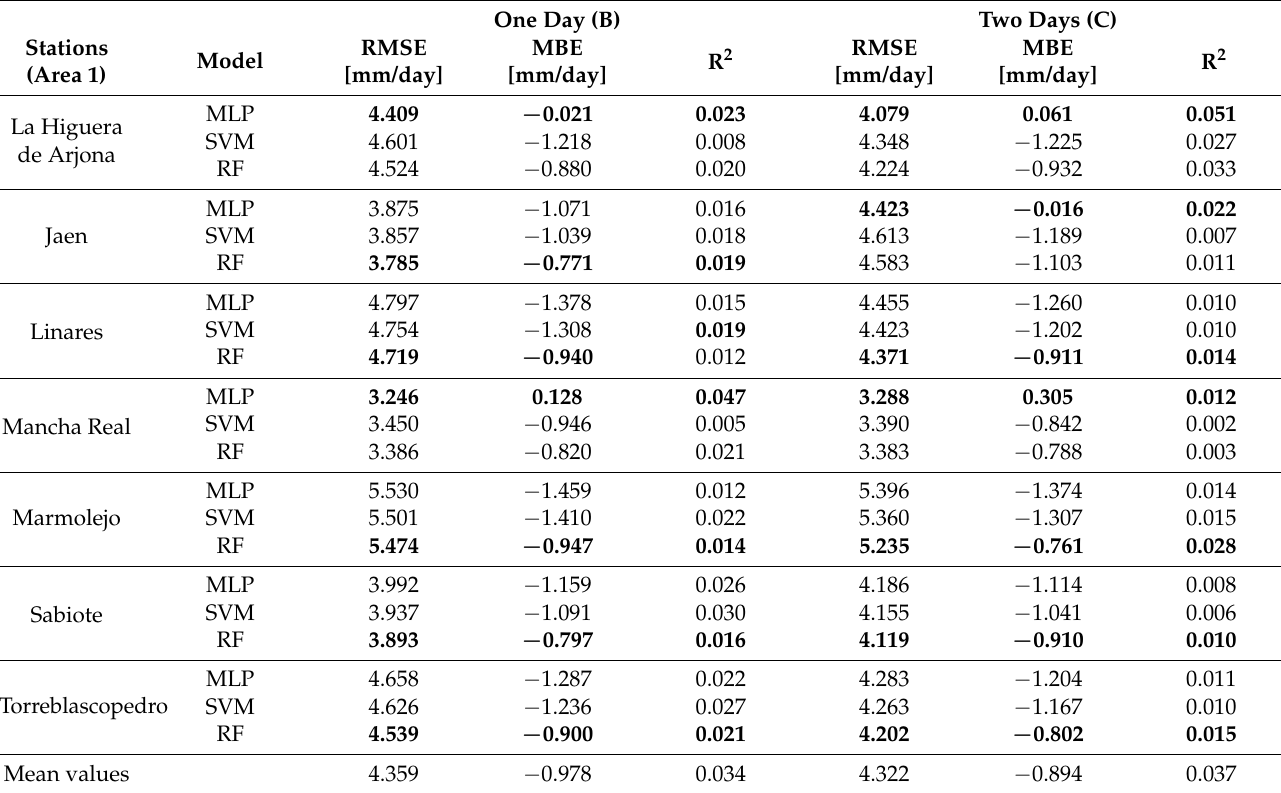
Table 6. RMSE, MBE, and R 2 performance values from testing dataset for all locations and models in the first area (inland locations), using data from the target station in two different approaches, with the use of the previous and following day and the use of the two previous and two following days. The best values from each station are in